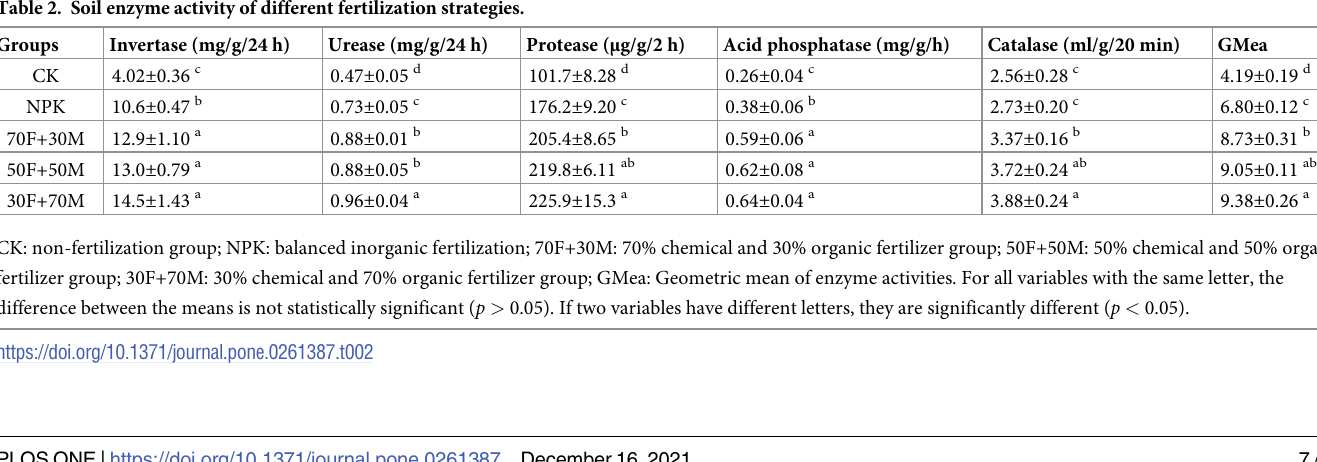
PLOS ONE | https://doi.org/10.1371/journal.pone.0261387 December16,